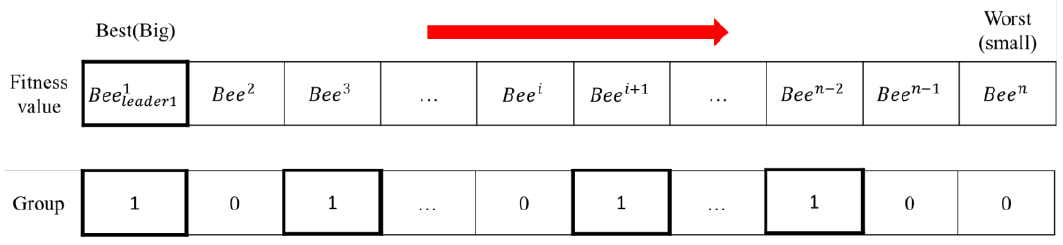
Figure 13. Similar bees assigned to same group.